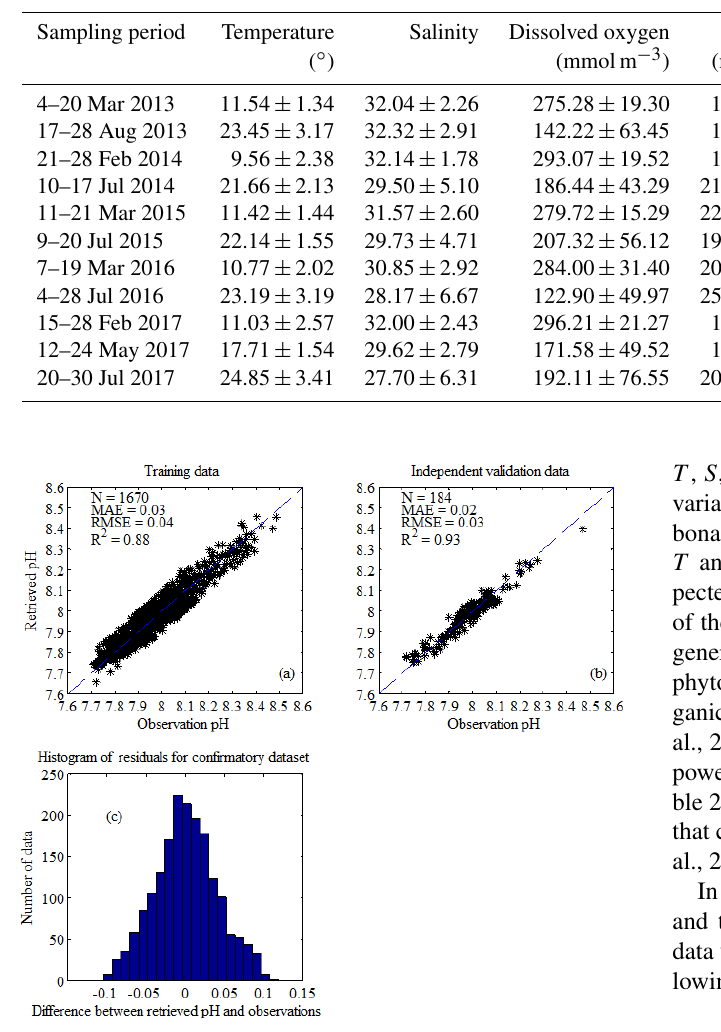
Figure 6. Comparison of pH T retrieved by the ANN model with corresponding observations. (a) Training data (90% of confirma- tory dataset); (b) independent validation data (10% of confirmatory dataset); (c) histogram of residuals for confirmatory dataset. The 1 : 1 line is shown in each plot as a visual reference. Three statistics are the mean absolute error (MAE), the coefficient of determina- tion ( R 2 ) and the root mean square error (RMSE). N represents the number of data